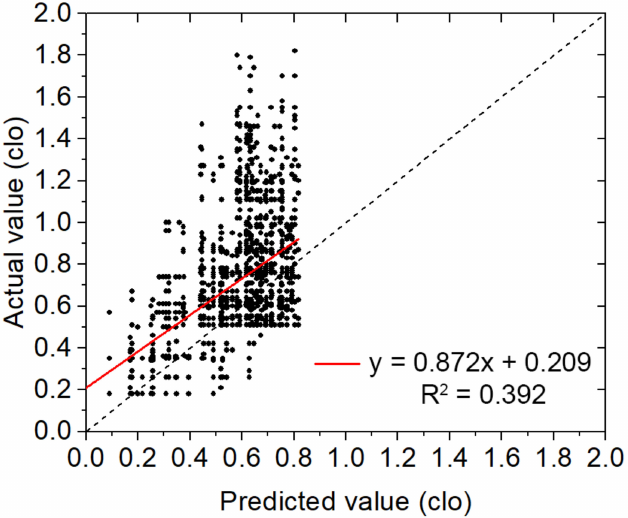
Figure 9. Relationship between the predicted values obtained from the ASHRAE 55 model and actual values.